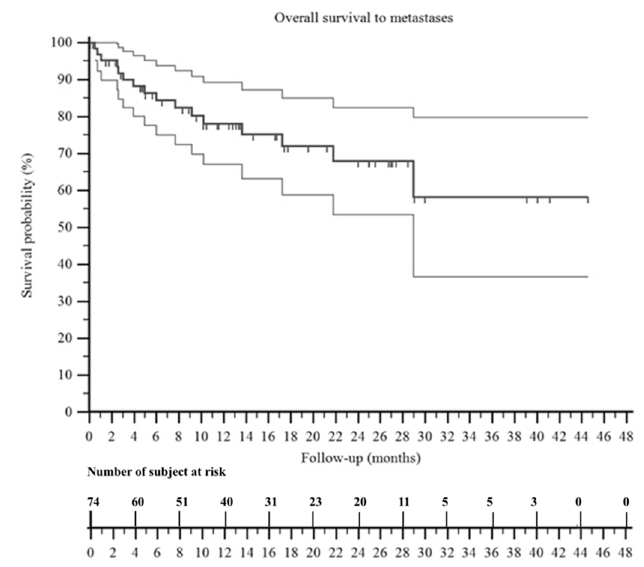
Figure 5. A Kaplan–Meier curve shows the survival to metastasis of the patients included in this series. It was 68% at 2 years and 58% at 3 years. The two surrounding thin black lines represent the 95% confidence intervals.